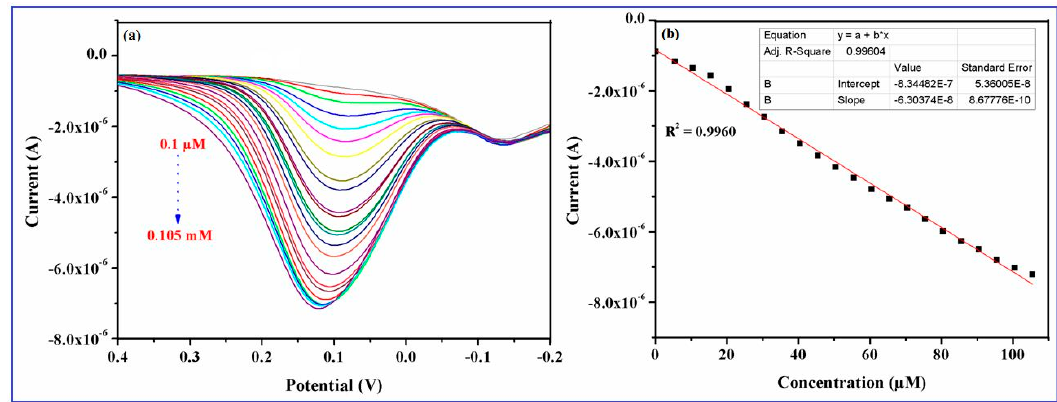
Figure 9. Differential pulse voltammetry (DPV) responses obtained for various concentrations of DA (0.1 µM to 0.105 mM) in 0.1 M phosphate buffer (pH 7.4) at a fixed scan rate 50 mV/s ( a ) CuO nanowires/GCE and ( b ) calibration curve plotted versus oxidation current and the molar concentration of dopamine (DA).